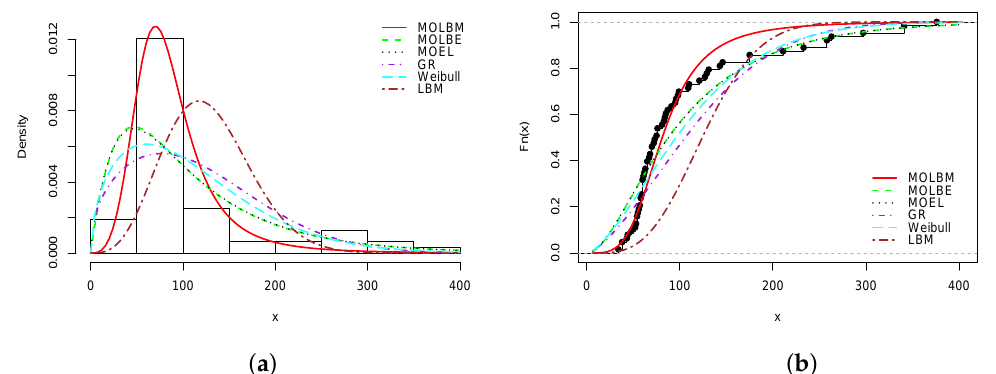
Figure 7. Plots of ( a ) estimated pdf and ( b ) estimated cdf of the MOLBM model with those of the other competitive models for Data set